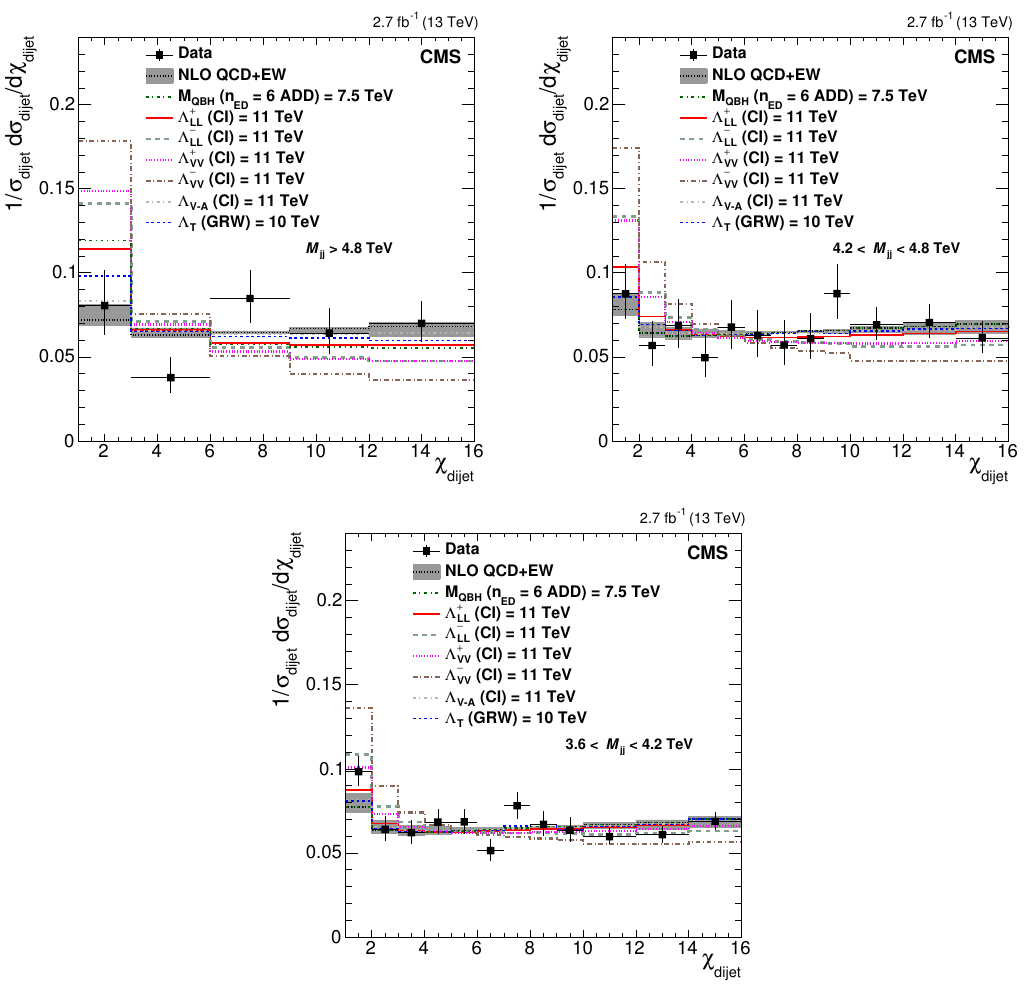
Figure 2 . Normalized (cid:31) dijet distributions for 2 : 6 fb (cid:0) 1 of integrated luminosity in the highest three mass bins. The corrected distributions in data are compared to NLO predictions with non- perturbative corrections (black dotted line). The vertical bar on each data point represents sta- tistical and systematic experimental uncertainties combined in quadrature. The horizontal bar indicates the bin width. Theoretical uncertainties are indicated by the gray band. Also shown are the predictions for various QBH, CI, and ADD